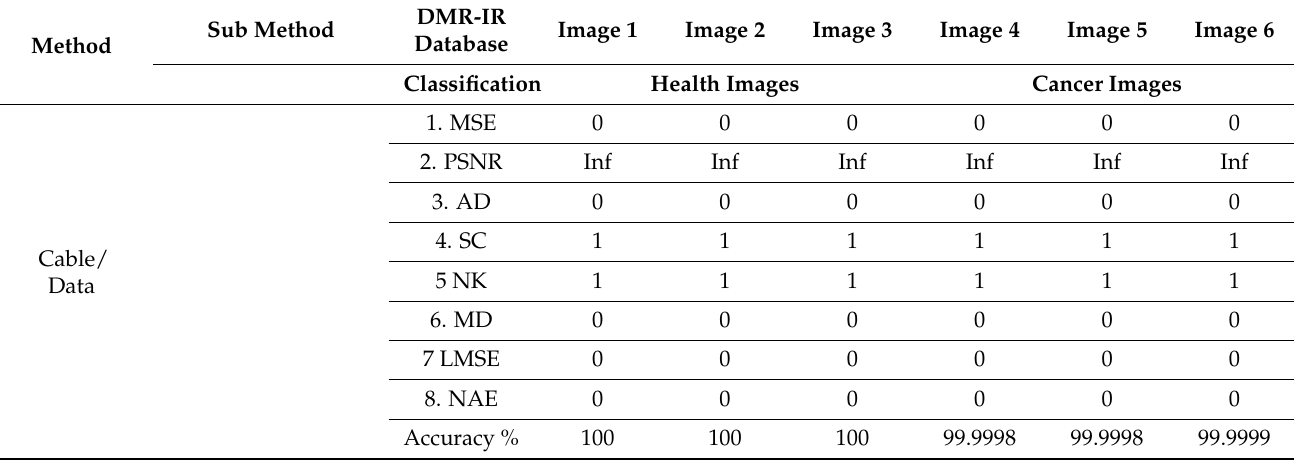
Table 2. Detection accuracy and quality of thermal images (DMR-IR database) after effects. Sub Method